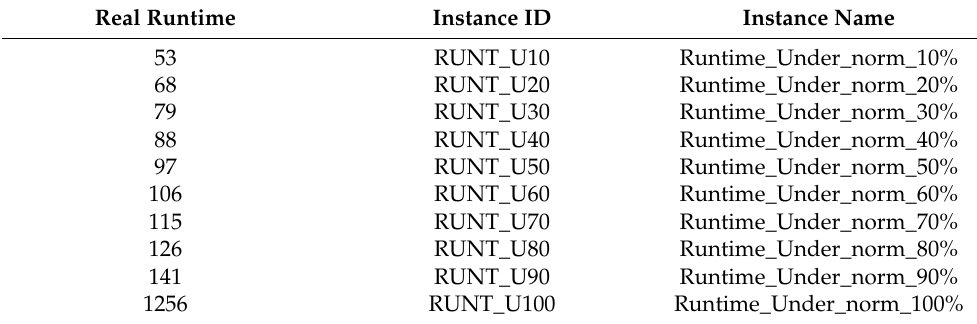
Table A5. Categorization criteria of “Runtime” class in the experiment.